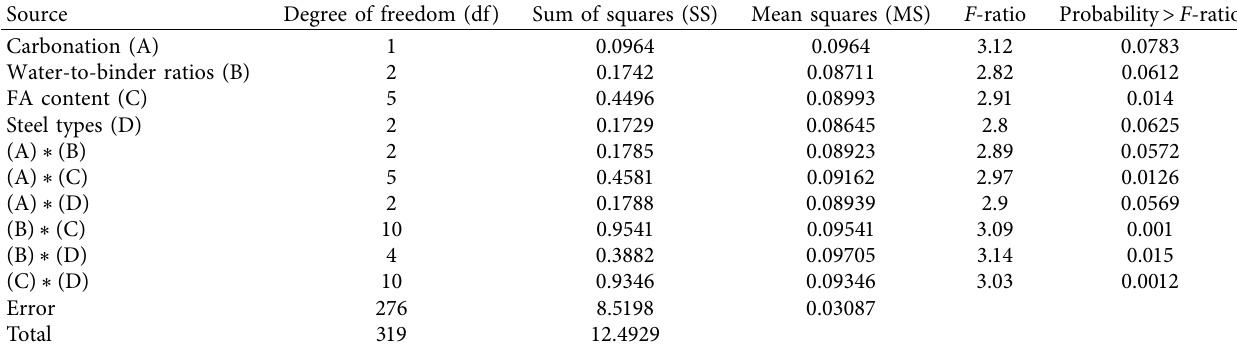
Table 9: ANOVA result for Icorr of carbonated